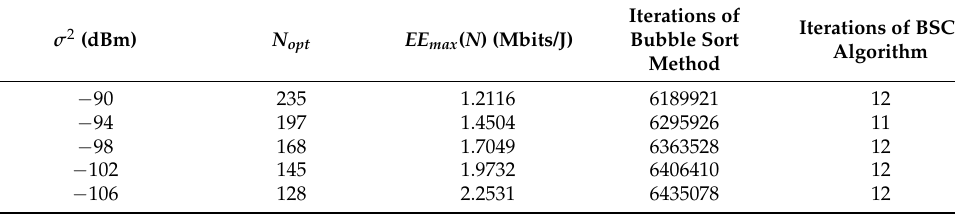
Table 4. N opt and iterations with different σ 2